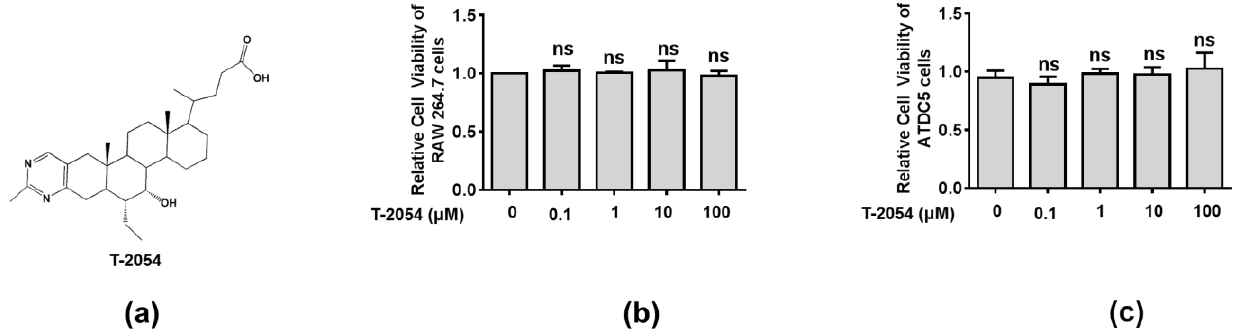
Figure 2. Detect the cell viability of RAW 264.7 cell and ATDC5 cell. Chemical structure of T-2054 ( a ). The RAW 264.7 cell and ATDC5 cell viability were measured by CCK-8 kits after exposure to different concentrations of T-2054 for 24 h ( b , c ). Each value represents the mean ± SD, performed in 3 different experiments. ns vs. T-2054 (0 μM).